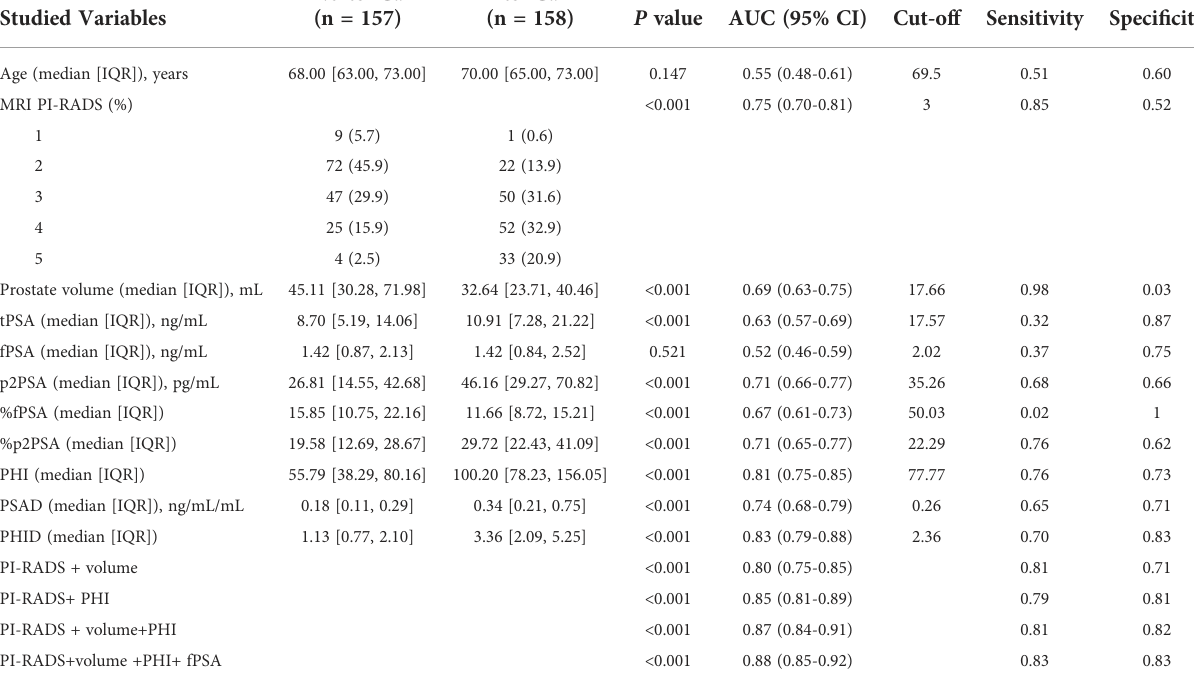
TheAUCofthematchingROCcurvewiththe95%con fi denceinterval(CI)isprovidedforeachvariable.AccordingtotheYoudenindexmaximization,thebestthresholdforthediagnosis ofPCaisprovidedwiththeachievedsensitivityandspeci fi city.Casesarede fi nedasindividualswithvaluesequaltoormorethanthethreshold,withtheexceptionofprostatevolume,which istheinverse.PI-RADS,ProstateImagingReportingandDataSystem;tPSA,totalprostatespeci fi cantigen;p2PSA,[ − 2]proPSA;%fPSA,freePSA/totalPSA;%p2PSA,p2PSA/freePSA;PHI, prostate health index; PSAD, PSA density, PSA/Prostate volume; PHID, PHI density, PHI/Prostate volume; AUC, area under curve; ROC, receiver operating characteristic.